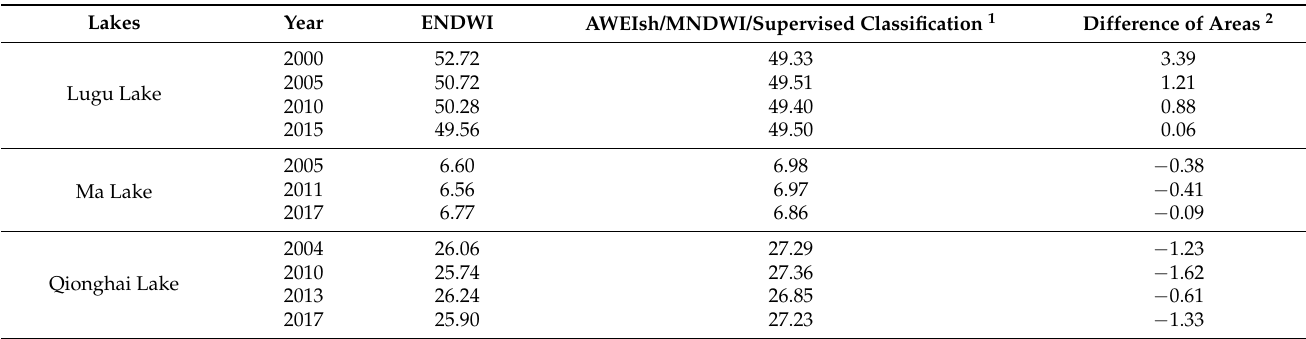
Table 4. Comparison of the results of different extraction methods (km 2 ).